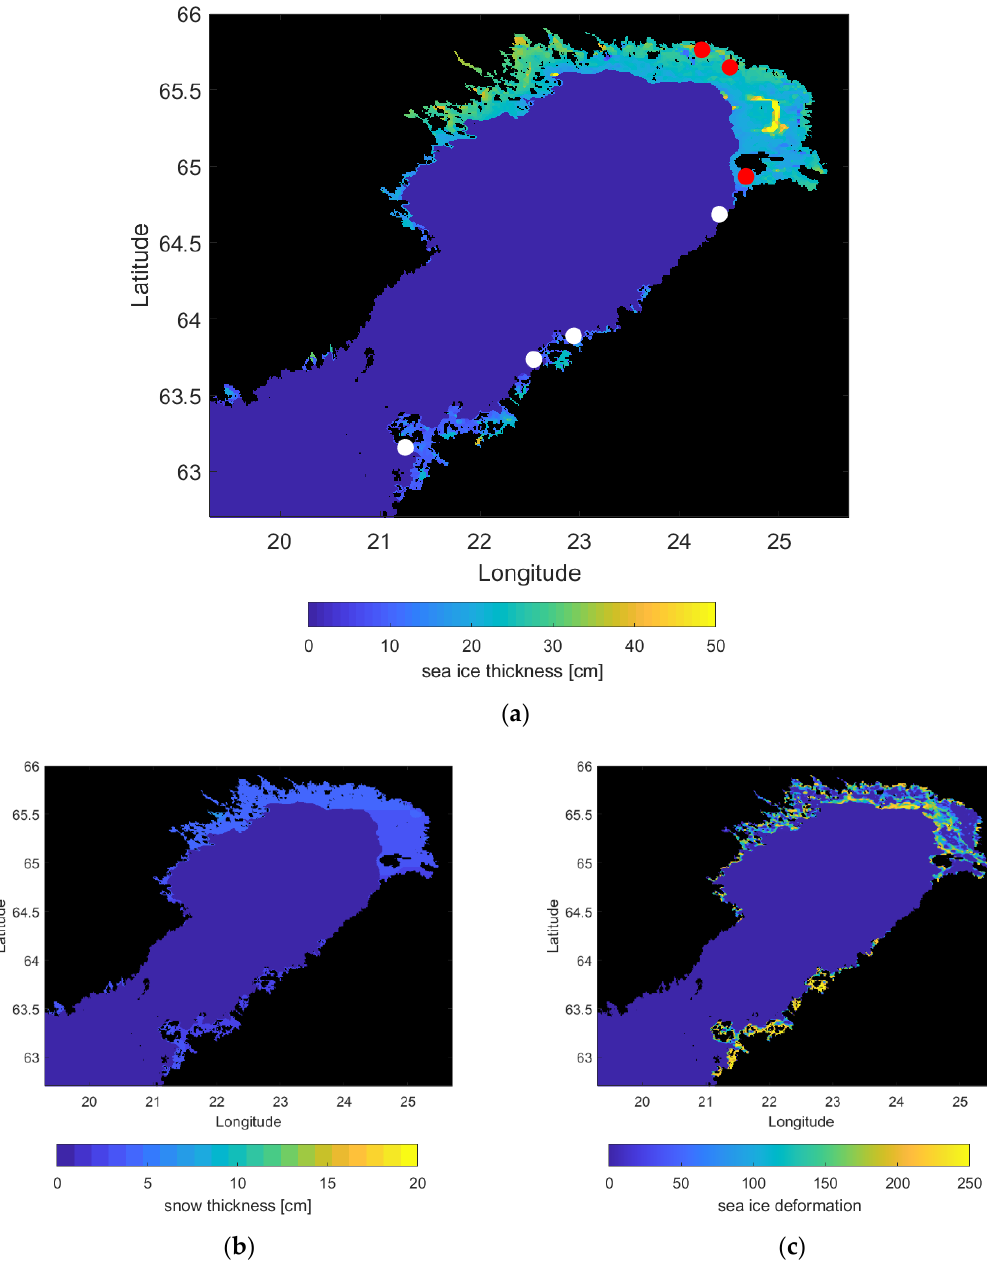
Figure 7. BALFI Baltic Sea landfast ice extent and ( a ) sea ice thickness, ( b ) snow thickness and ( c ) degree of ice deformation charts on 5 March 2020 for the Bay of Bothnia. The locations of three FIS coastal ice stations in the Bay of Bothnia with long time series of data in 2019–2020 are shown with red dots in ( a ), and four other stations with much shorter periods of data with white dots. The sea ice and snow thickness data from the stations are used in the validation of the BALFI